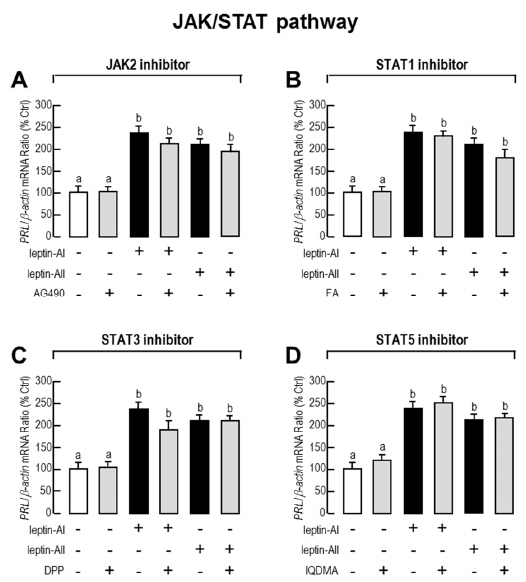
Figure 3 . Effects of JAK/STAT signal pathway blockers on leptin-stimulated PRL mRNA levels in primary cultured goldfish pituitary cells. Goldfish pituitary cells were treated with leptin-AI (100 nM) or leptin-AII (100 nM), in the presence or absence of JAK2 inhibitor AG490 (50 µ M, A ), STAT1 inhibitor FA (10 µ M, B ), STAT3 inhibitor DPP (500 nM, C ), and STAT5 inhibitor IQDMA (20 µ M, D ) for 24 h. In the present study, the data are expressed as mean ± SE ( n = 4). The same letter represents a similar level of transcriptional expression ( p > 0.05), and a different letter represents significant difference in levels of transcriptional expression between two groups ( p < 0.05). Int. J. Mol. Sci. 2017 , 18 , x